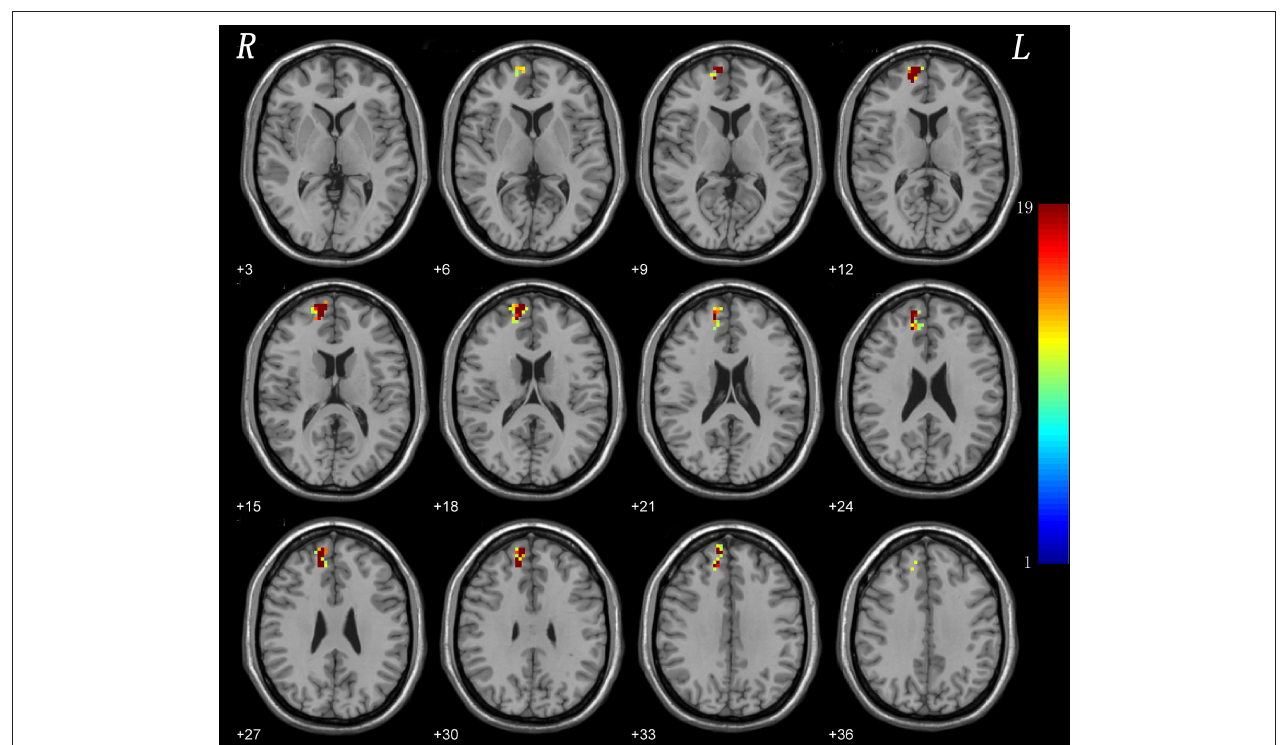
FIGURE 3 | Leave-one-out validation. The group comparisons based upon the permutated samples (i.e., 18CD vs. 21 healthy controls) for total 19 times. For each voxel, the color indicates number of tests where this voxel exhibited significant group differences across the total 19 tests (i.e., the reproducibility).